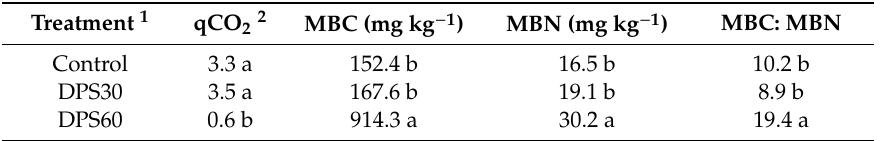
Table 5. E ff ect of di ff erent deinking paper sludge (DPS) doses on microbial metabolic quotient (qCO 2 ), microbial biomass carbon (MBC) and nitrogen (MBN), and the MBC:MBN ratio in a calcareous soil after 95 days of